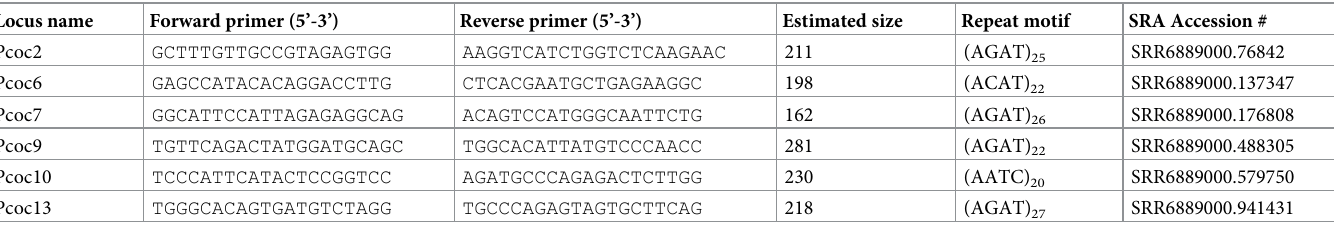
Table 3. Details of the six microsatellites developed from Illumina shotgun sequence data that were heterozygous in female WD-10 Asian Water Dragon ( Phy- signathus cocincinus ). We used the shotgun library sequence to estimate the size of the amplicon